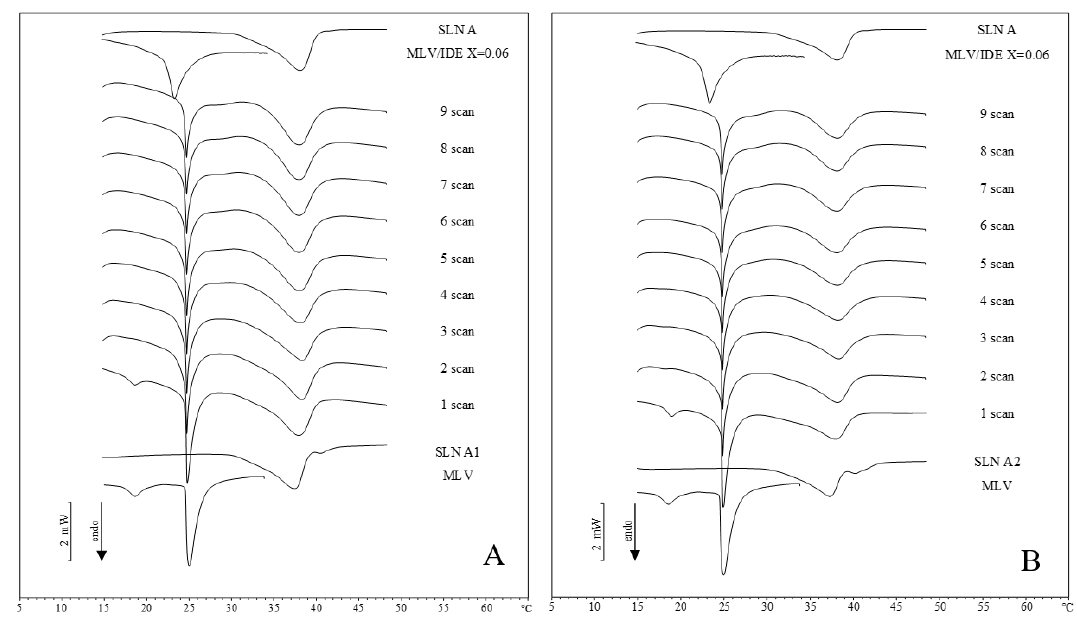
Figure 3. DSC scans during the interactions of IDE-loaded SLN with MLV liposomes. A = SLN A1; B = SLN A2.